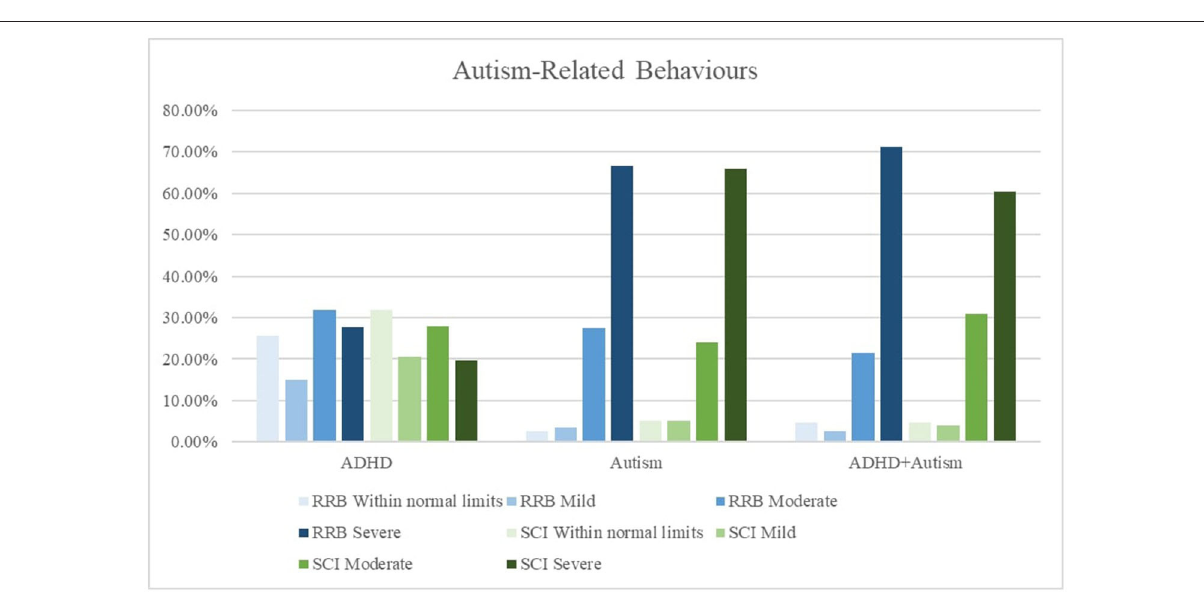
co-occurring diagnoses and symptoms and pharmacological management for ADHD, autism and ADHD + autism